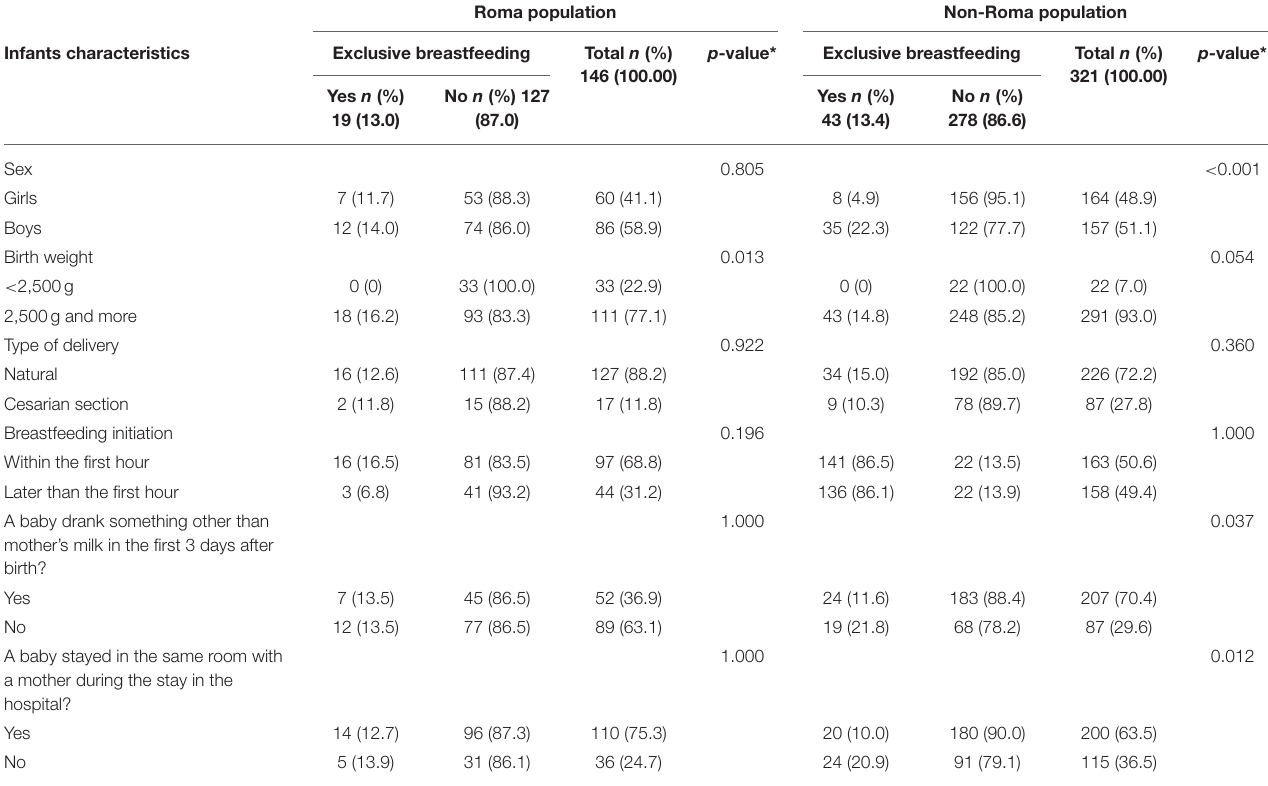
TABLE 2 | Infant’s characteristics and practice of exclusive breastfeeding under the age of 6 months. Roma population Non-Roma